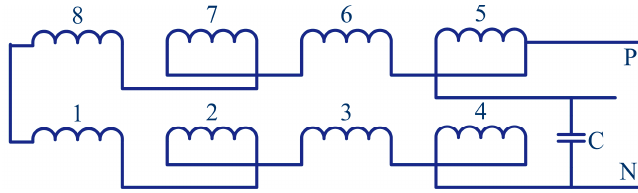
Figure 1. Proposed induction motor winding arrangement for working as a single-phase motor.